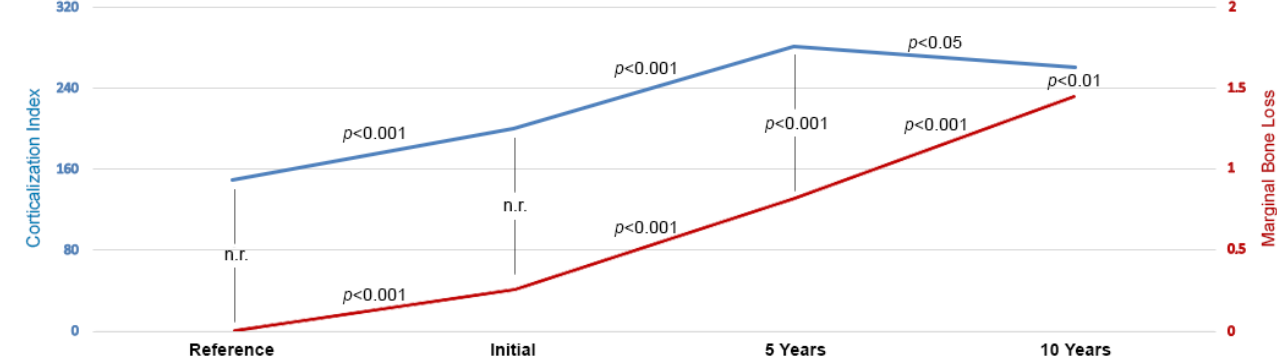
Table 3. Presentation of included population. Assessment of the impact of baseline epidemiological data on the corticalization index observed in peri-implant bone.